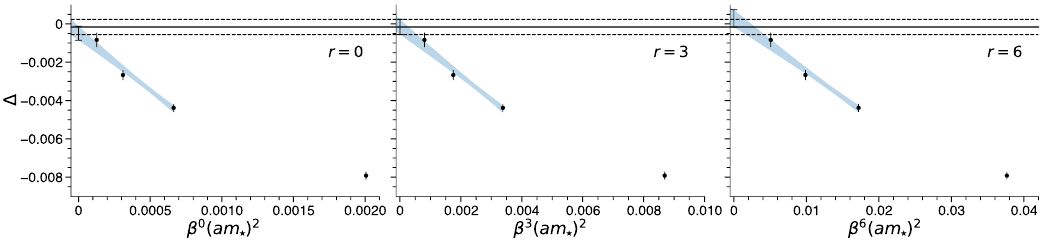
Figure 1 . Illustration of the continuum limit procedure for tC ( t ) | m . Three different extrap- ? t =0 . 5 olation forms are employed using eq. (4.7) with r = 0 , 3 , 6 . Shown is the difference between the numerical estimate and the exact result divided by the exact result, denoted ∆ . The horizontal band indicates our estimate for the continuum extrapolated ∆ , given by the intercept from the fit with r = 3 . The statistical error on this estimate is similar to the variation across the three values of r , which is taken as an estimate of the systematic error. This validates the use of the ‘phenomenological’ extrapolation forms in eq. (4.7) for ρ (cid:15) ( E ) , for which the statistical errors are